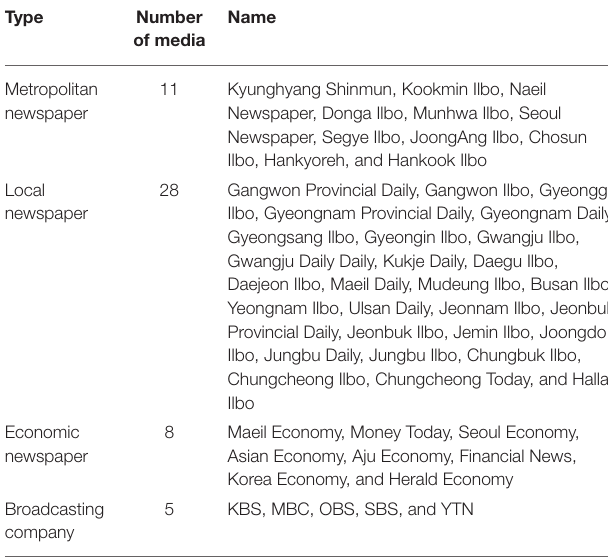
TABLE 1 | The analyzed media.